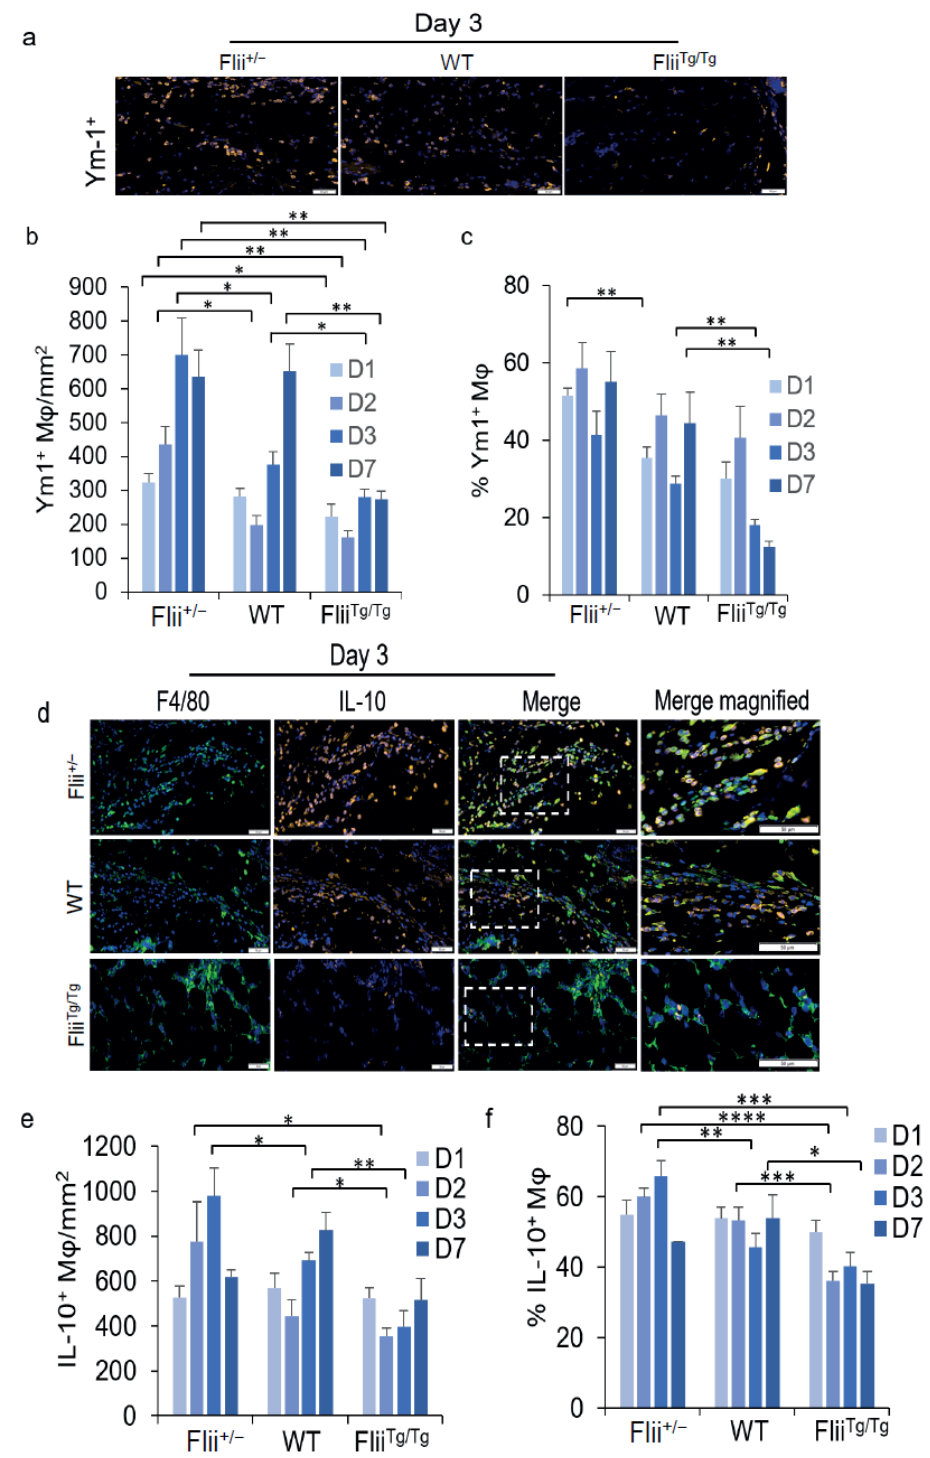
Figure 4. Expression of Ym1 and IL-10 positive macrophages in the wounds from 3 Flii genotypes (Flii +/ − , WT, and Flii Tg/Tg ): ( a ) Day 3 representative images of wounds immunostained for F4/80 and Ym1, ( b ) the cell counts and ( c ) percentages of Ym-1 + F4/80 + macrophages present in the wounds of the 3 Flii genotypes ( n = 6); ( d ) Day 3 representative images of wounds immunostained for F4/80 and IL-10; and ( e ) The cell counts and ( f ) percentages of IL-10 + F4/80 + macrophages present in the wounds of the 3 Flii genotypes ( n = 6). Scale bars = 50 µ m. Results are expressed as mean ± SEM. * p < 0.05, ** p < 0.01, *** p < 0.001, and **** p <